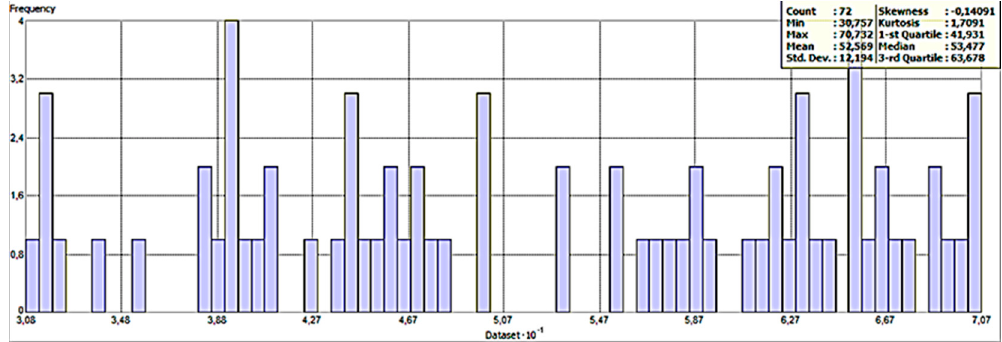
Figure 8. The histogram of the apparent soil ER (Electrical Resistivity) values.